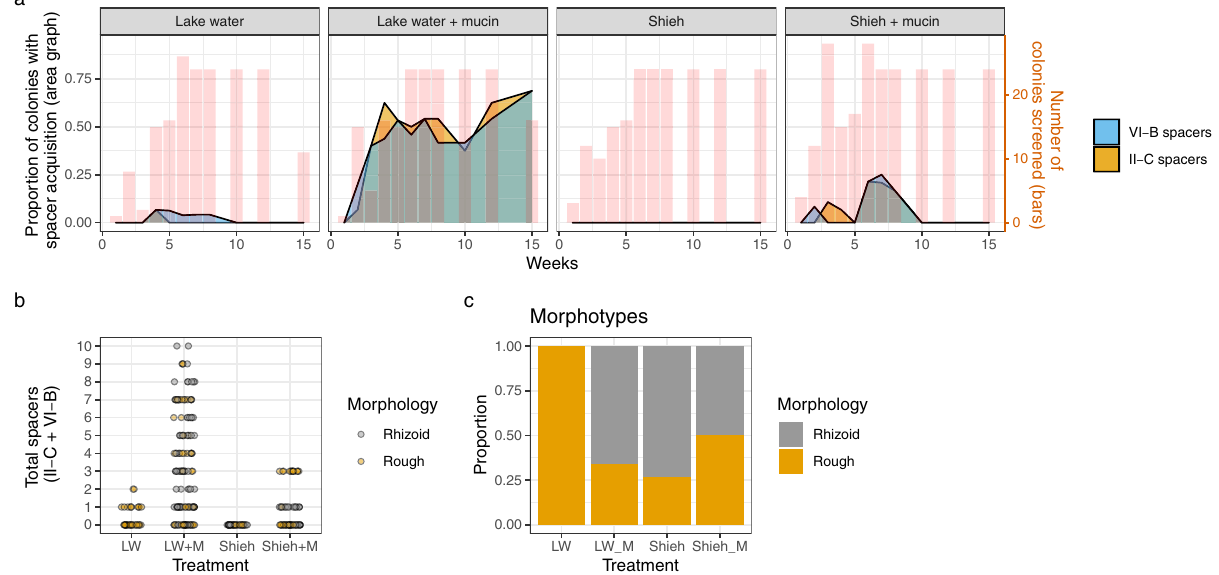
Fig. 3 Dynamics of CRISPR spacers and colony morphotypes. a CRISPR-Cas spacer acquisition over time in both loci. The area graphs (left Y-axis) represents the proportion of colonies in which the CRISPR-Cas array expanded by at least one new spacer. Values are means from the three replicates. The red columns (right Y-axis) show the total number of colonies that were screened at each time point to obtain these proportions. Missing red bars indicate no screening on that week – the respective proportional data is, therefore, an interpolation. b The absolute number of spacers from individual isolates in different treatments. New spacers in both loci have been added together. c Morphotype distribution across the treatments (isolates from all time points pooled together). Source data are provided as a Source Data fi